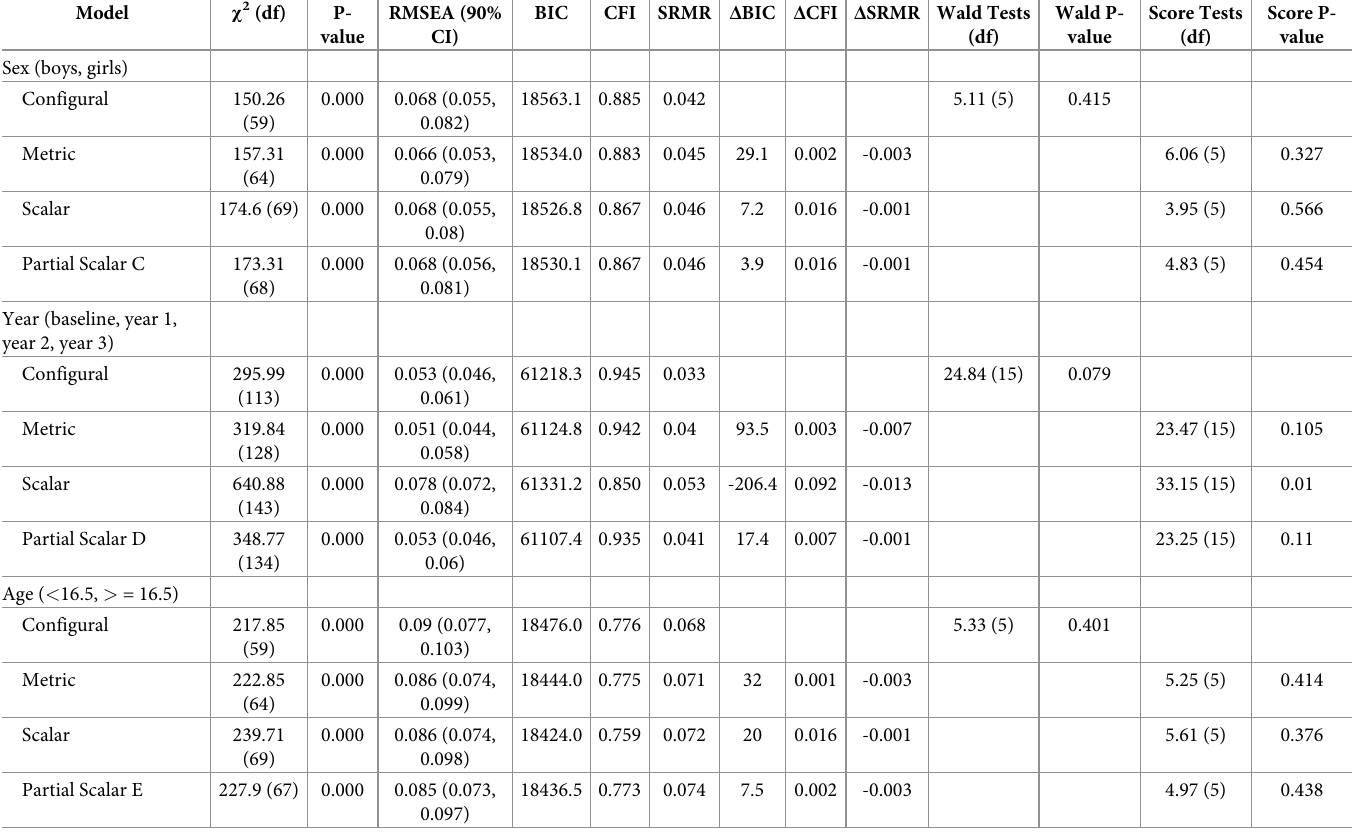
Table 4. Invariance tests for the 8-Factor Model applied to the Penn CNB test suite.